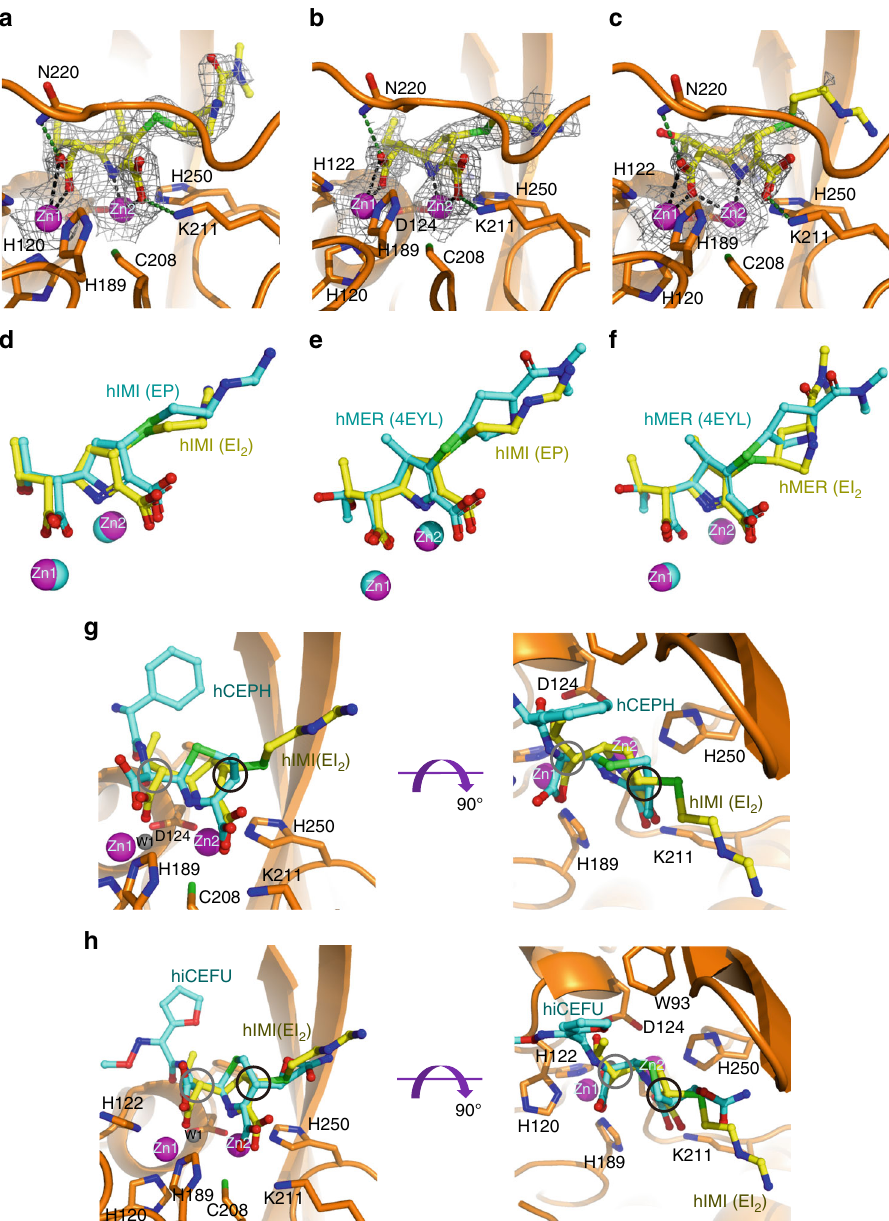
Fig. 3 Close-up views of the active site of NDM-1 representing different enzyme-intermediate/product adducts. a – c Zinc centers bound by hydrolyzed meropenem in EI1 ( a ), or imipenem in EI2 ( b ), or EP ( c ). The 2 F o – F c electron density is contoured at 1.0 σ and shown as gray mesh. Metal coordination bonds and hydrogen bonds with N220 and K211 are denoted by dashed lines in black and green, respectively. d – f Overlay of imipenem in EI 2 and EP ( d ), imipenem in EP, and meropenem in structure 4EYL 19 ( e ), or meropenem in EI 2 and that in structure 4EYL 19 ( f ). g , h Overlay of hydrolyzed imipenem in EI 2 with cephalexin ( g ), or cefuroxime ( h ) 24 . C2 and C6 in imipenem are highlighted by black and gray circles, respectively. Zinc ions are represented by magenta spheres in all